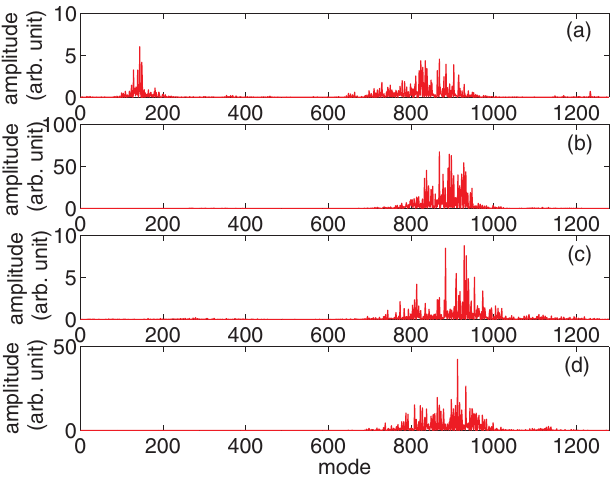
FIG. 16. (Color) Mode spectrum given by Fourier transforma- tion of the amplitude evolution. Plots (a) and (b) depict the horizontal and vertical spectra, respectively, for electrons emit- ted at the illuminated point. Plots (c) and (d) depict the situation for electrons emitted uniformly. Secondary electron rate is (cid:1) 1 : 0 and a reflection of (cid:3) (cid:1) 0 : 5 . (cid:3) 2 ; max 0 modes, m (cid:1) 100 – 200 . These pictures can be compared with Figs. 7(a) and 8(a), respectively. The mode spectra are qualitatively coincident with those given by the wake force. Plots (c) and (d) depict the situation for electrons emitted uniformly. Figure 17 shows the same situation for (cid:1) 1 : 5 and a reflection of (cid:3) (cid:1) 0 : 5 . Other unstable (cid:3) 2 ; max 0 modes are now seen around 1100.